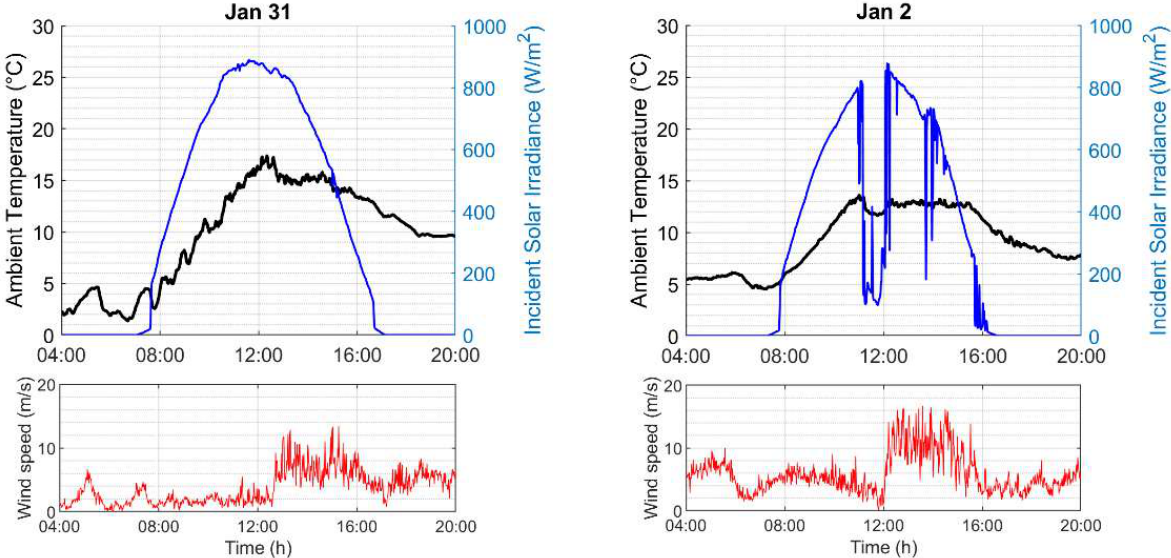
Figure 5. Ambient temperature, solar irradiance, and wind speed on 31st January and 2nd January.